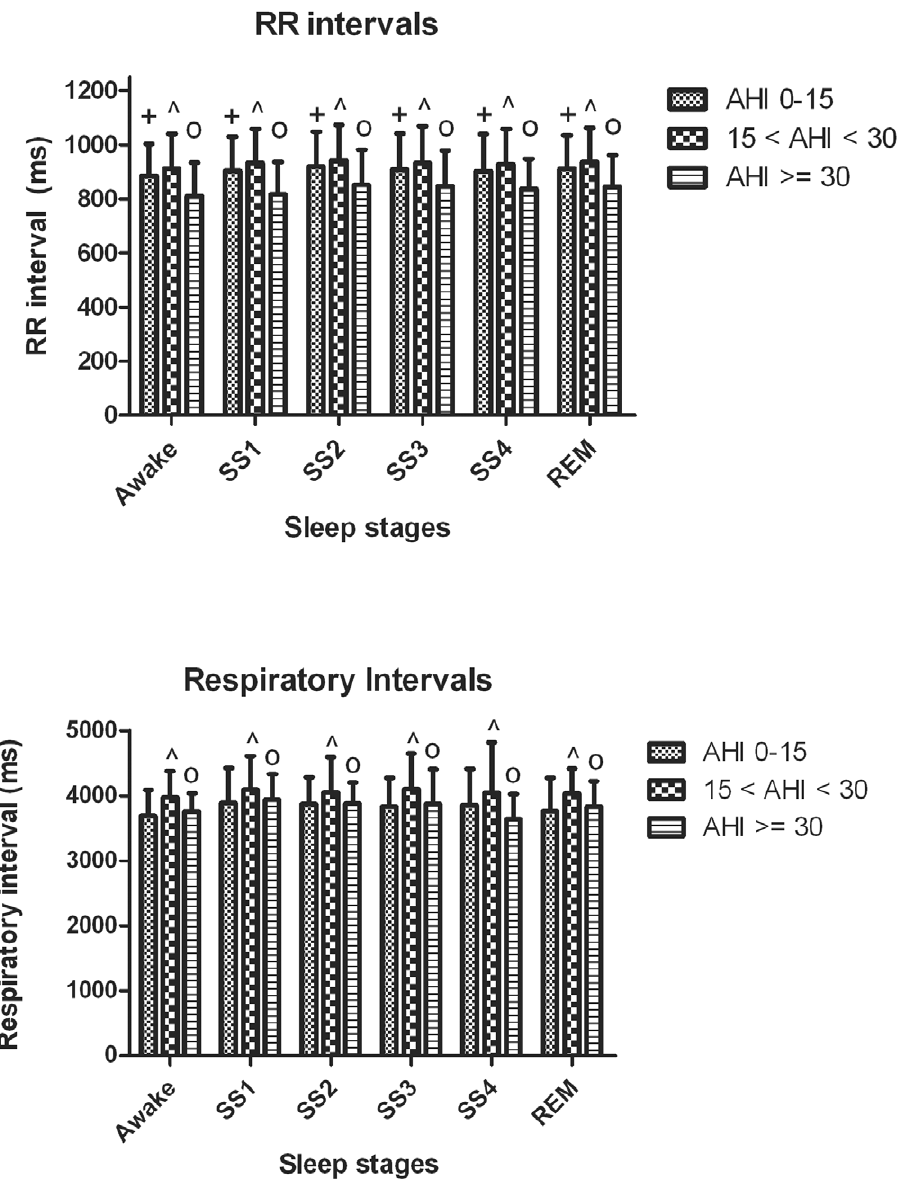
Figure 5. Group and sleep related comparison of RR interval and respiratory interval. The plus indicates that the differences in RR interval between the no/mild and severe OSA groups are significant ( p , 0.0001). Similarly, the circle and hat indicates the significance ( p , 0.0001) in RR interval or respiratory interval differences between moderate and severe or no/mild OSA groups respectively.